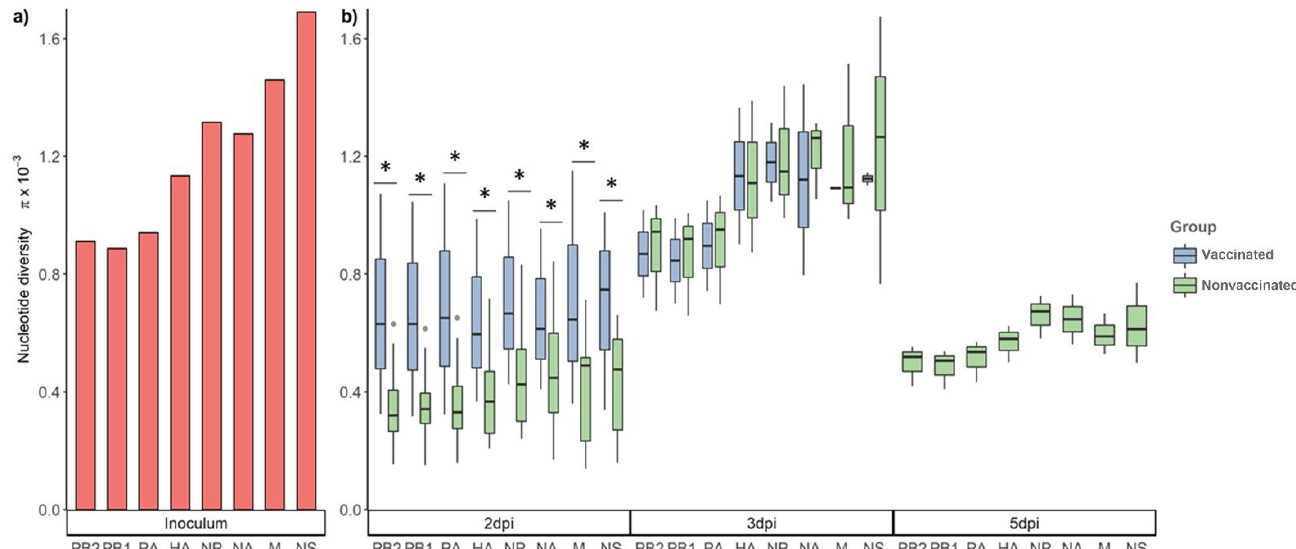
Figure 5. Nucleotide diversity ( π ) in the viral population at different time points. ( a ) Nucleotide diversity bars of inoculum sequence. ( b ) Box plot of viral population nucleotide diversity from all collected samples at 2, 3, and 5 dpi from vaccinated and nonvaccinated groups. Whiskers represent variability outside the lower and upper quartiles of each represented box. * p < 0.05.